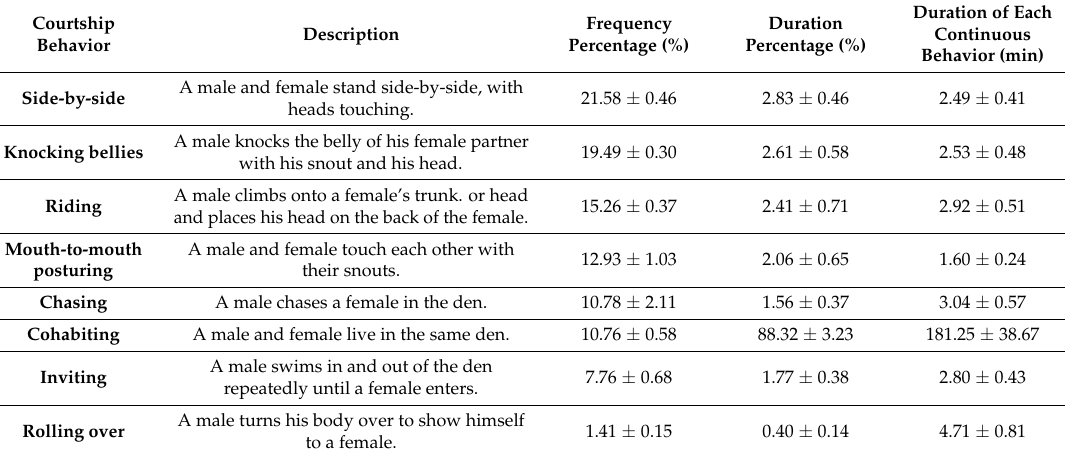
Table 3. Description of courtship behavior of A. davidianus